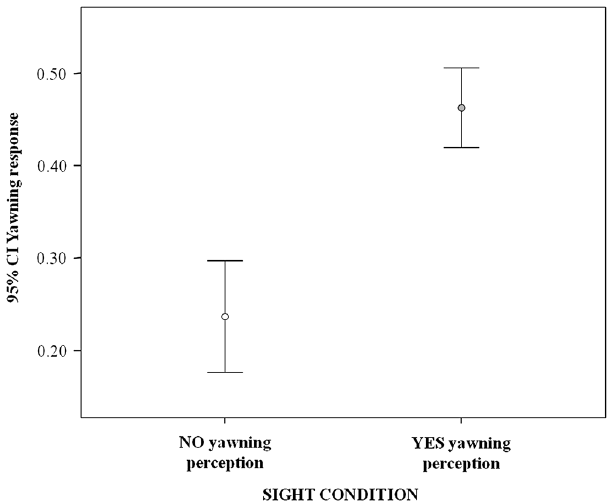
Figure 2. Error bars (mean, 95% confidence interval) showing the occurrence of yawning response (Y axis) as a function of the sight condition (X axis): "YES yawning perception"—the subject yawns after that another subject has yawned within its visual range (yawn condition); "NO yawning perception"—the subject yawns without perceiving a previous fellow’s yawn (control condition). The variable has a significant main effect on the yawning response (results of Model 1 included in Table 1). CI confidence interval.